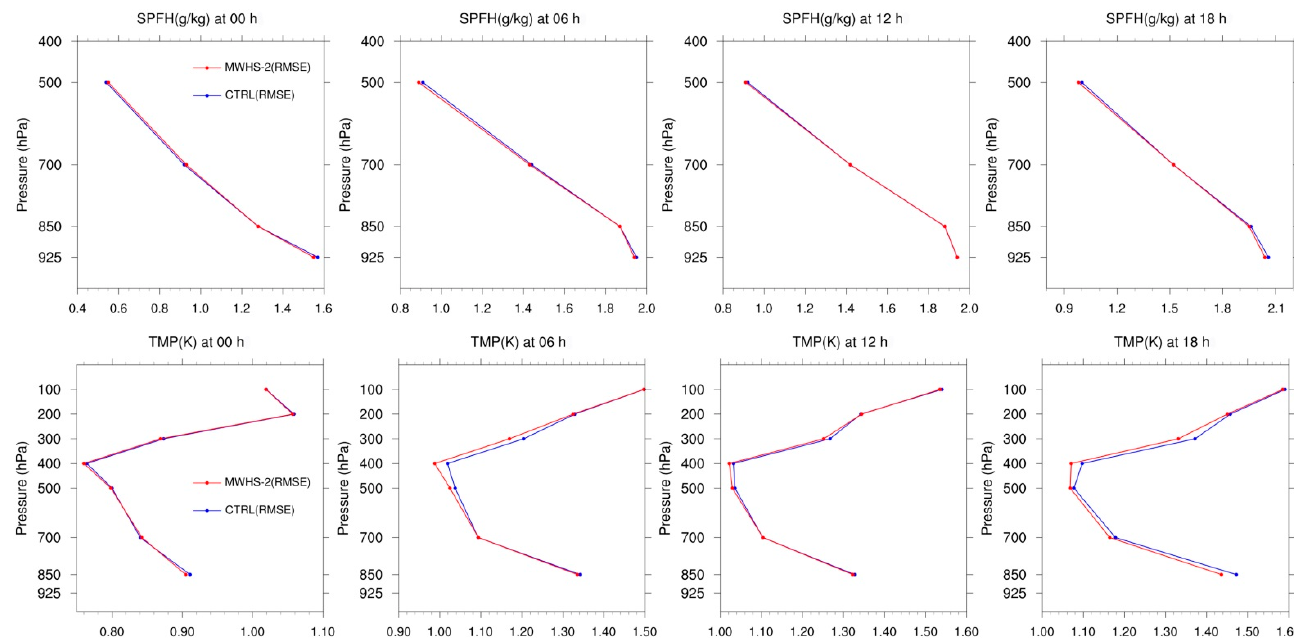
Figure 7. RMSEs of the forecast humidity (first row) and temperature (second row) profiles for CTRL (blue line) and MWHS-2 (red line) experiments against observations at 00 h, 06 h, 12 h and 18 h of the forecasts.